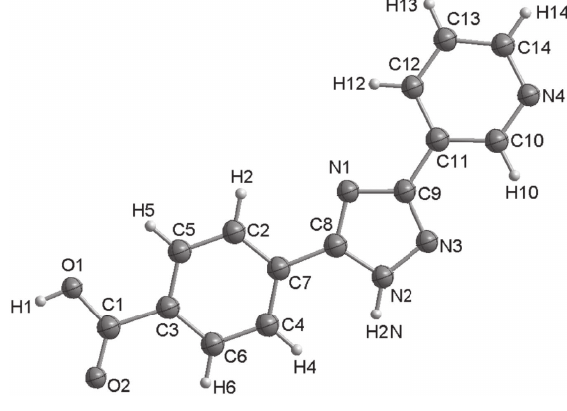
Table 2: Fractional atomic coordinates and isotropic or equivalent isotropic displacement parameters (Å 2